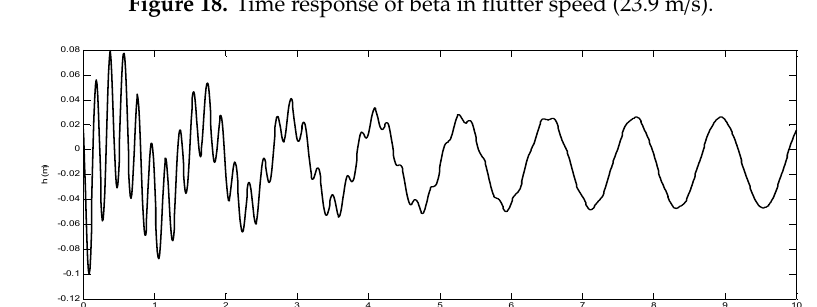
Figure 19. Time response of “h” in flutter speed (23.9 m/s).